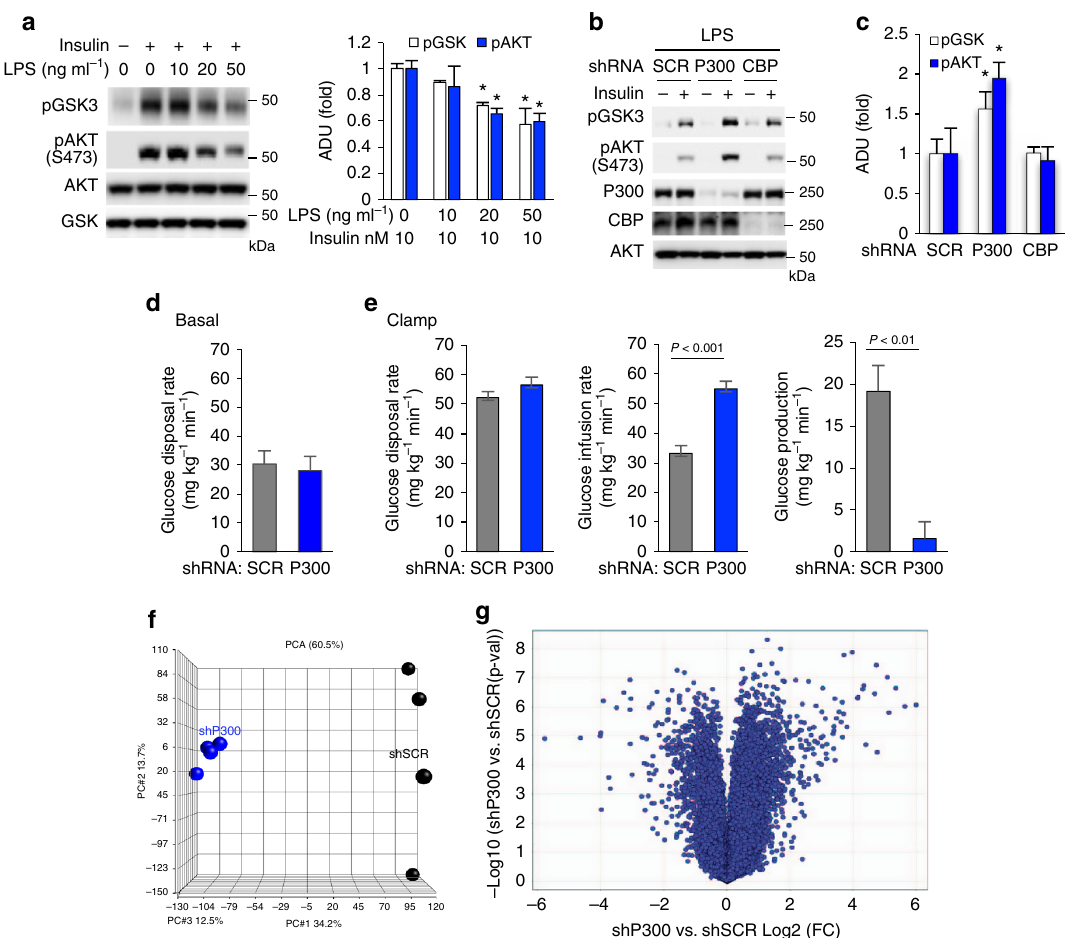
Fig. 5 Depletion of P300 improves insulin sensitivity. a Hepa1-6 cells were treated with the indicated concentration of LPS for 48 h then insulin (10 nM, 20 min). ( right ) Densitometric analysis of pAKT and pGSK3 in cells treated with insulin ( n = 3). b , c Hepa1-6 cells were treated with SCR, CBP and P300 adenoviral shRNA for 24 h, then LPS (500 ng ml − 1 ) for 24 h followed by treatment with 10 nM insulin (20 min) b and densitometric analysis of pAKT and pGSK3 in cells treated with insulin c ( n = 3). d , e 48 h after the injection of adenoviral shRNAs, mice were subjected to 5 h fasting before the clamp ( n = 5/group). Basal glucose production in mice after 5 h fasting d and Glucose disposal rates, glucose infusion rates and hepatic glucose production e during the clamp experiment. f PCA was performed on differentially expressed genes from the liver of mice with SCR or P300 AAV-shRNA injection. g Volcano plot is used to analyse differential expression of hepatic genes, and to show the fold change and statistical signi fi cance. SCR, scrambled shRNA. Each bar represents the mean ± s.e.m. *, P < 0.05, Student ’ s t